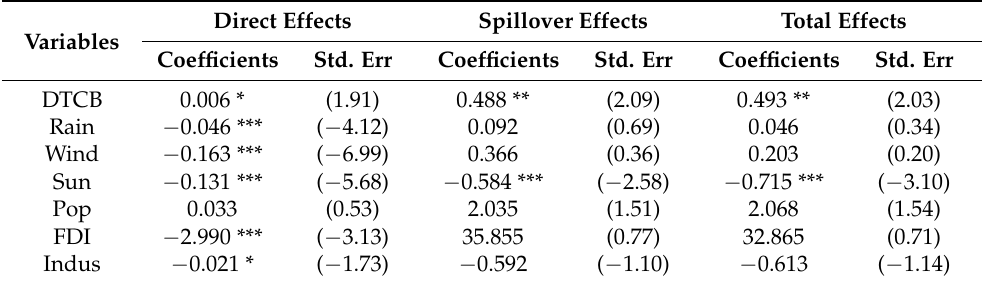
Table 7. Robust test using different weight matrix.